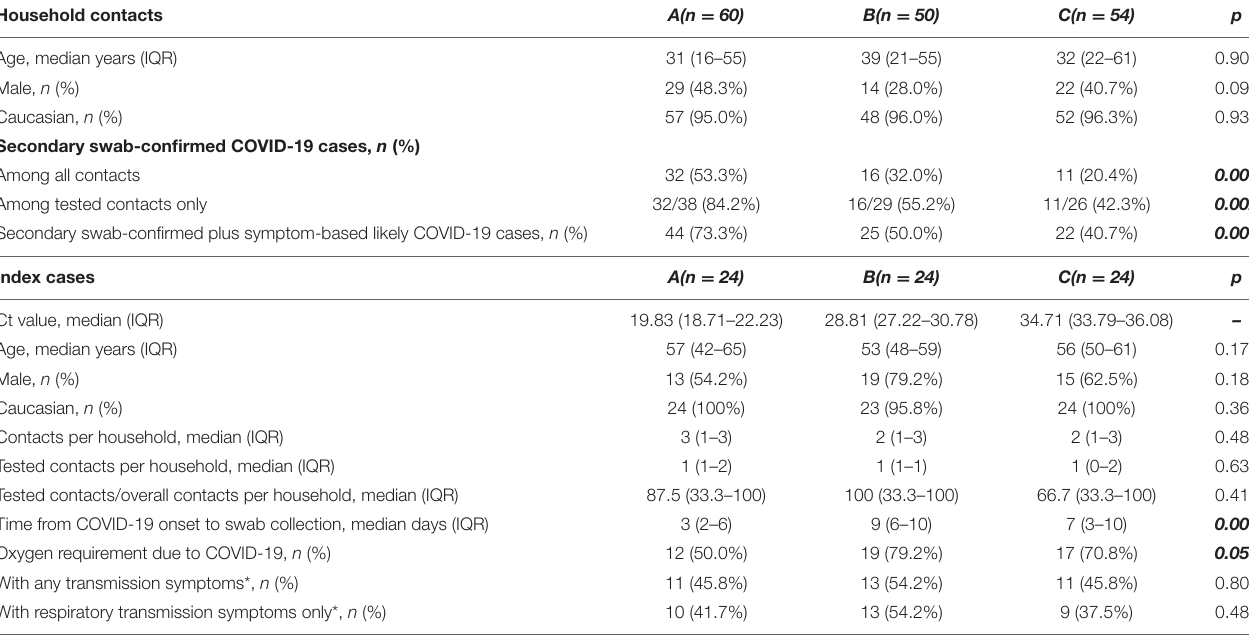
TABLE 1 | Comparison of demographic, clinical, and household characteristics between contact cases (upper table) and between index cases (lower table). Household